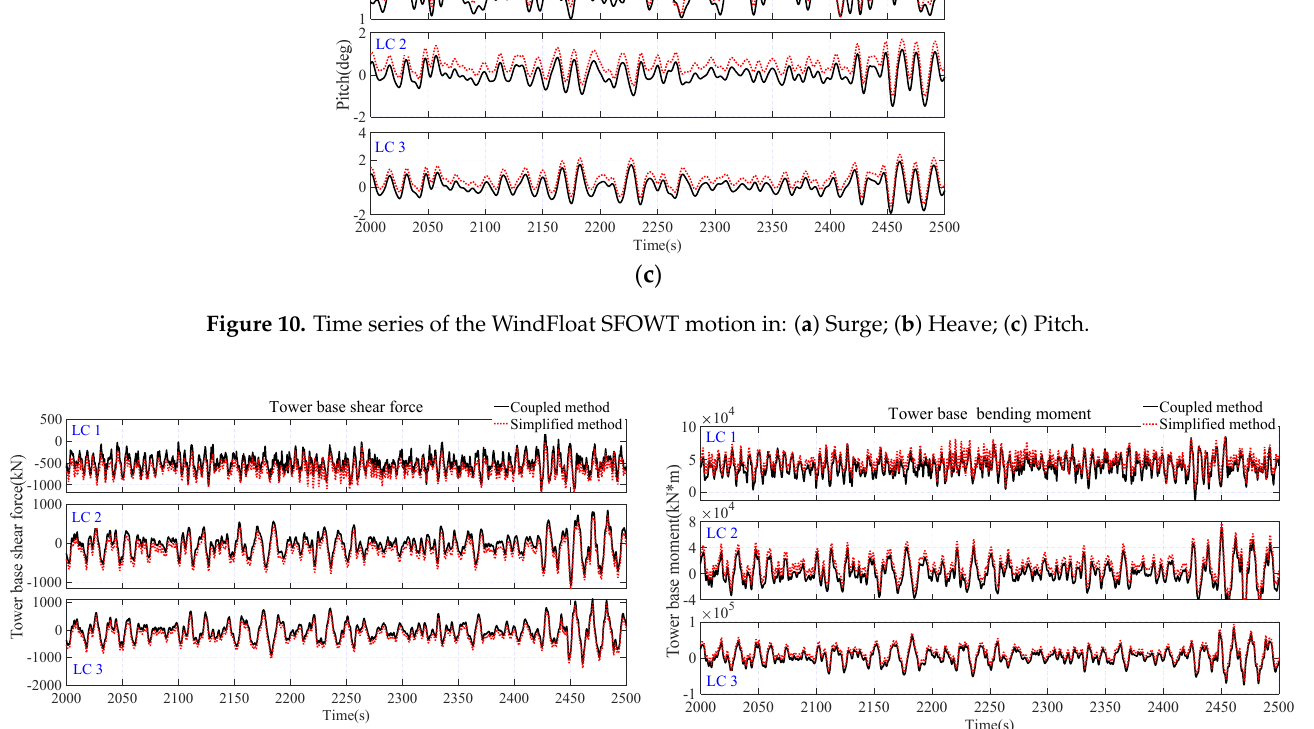
line tensions for different load cases. It should be noted that only the tension forces of ML